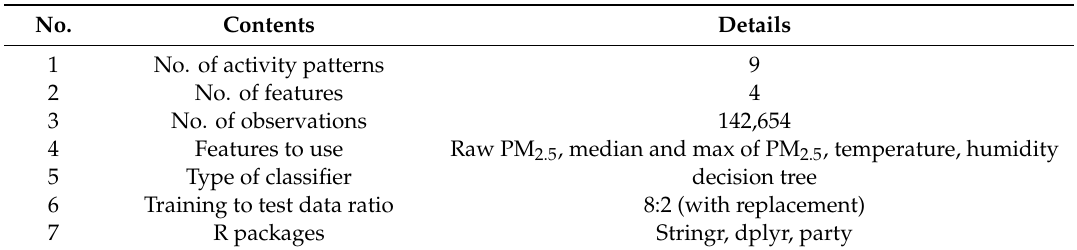
Table 1. Experimental setup.